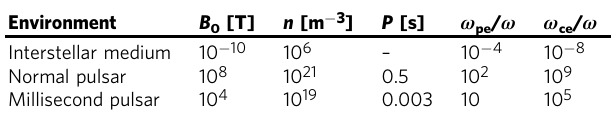
Table 1 Plasma parameters in different environments along the path of pulsars radio-signal